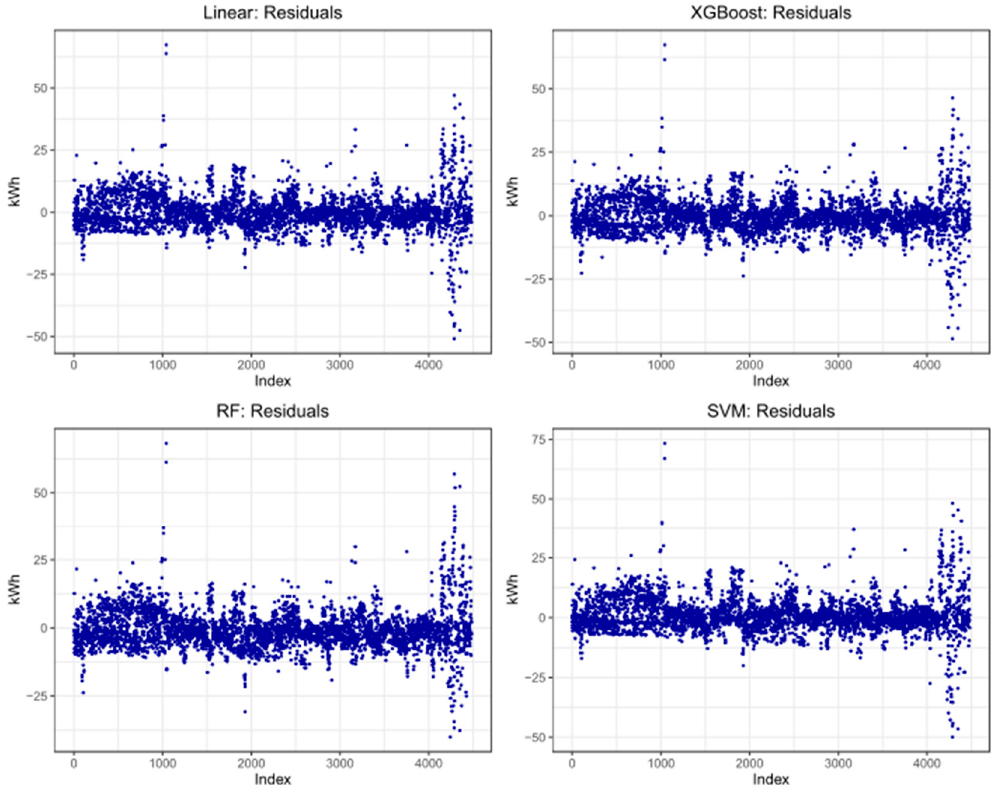
Figure 8. Residuals for each method—indices are grouped by user, then time.